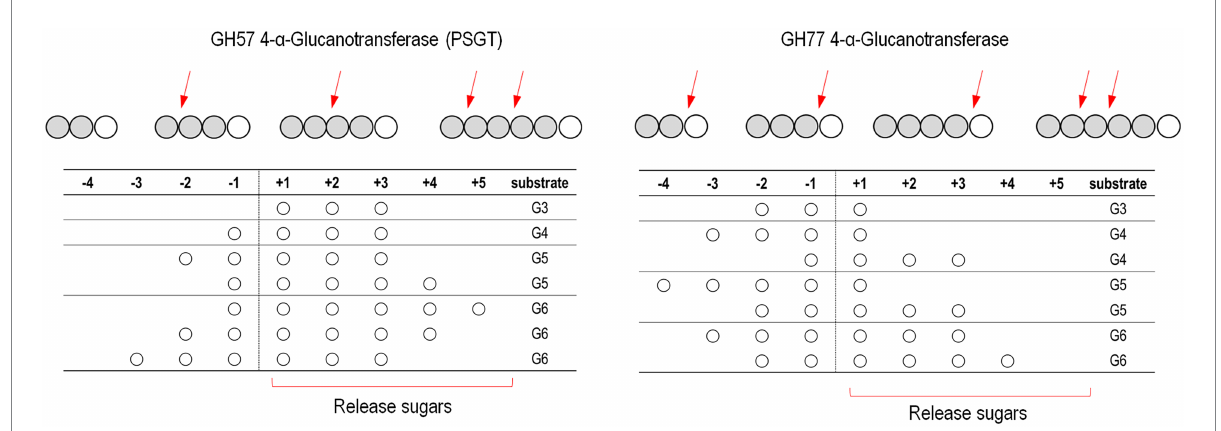
FIGURE 5 Schematic representation of the binding modes of maltooligosaccharides of GH57 (PSGT) and GH77 4- α -GTase. The numbering indicated that substrate binding subsites. The α -1,4-glucosidic bonding of substrates is cleaved between subsite − 1 and + 1. Red arrow means dominant cleavage site of various substrates. The binding modes of GH77 4- α -GTase was represented based on the experimental data reported by Jung et al. (2011) and Kaper et al. (2007)